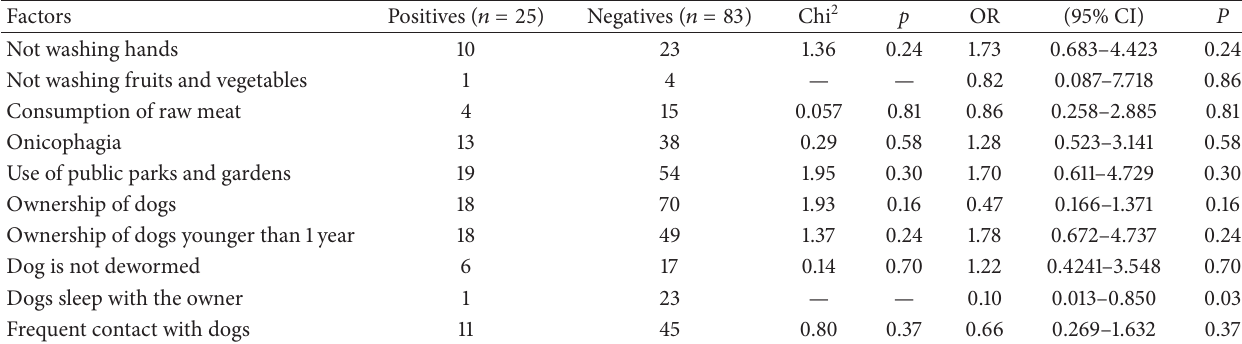
Table 3: Some factors evaluated for their association with toxocariasis serology in children from Ecatepec, Mexico.